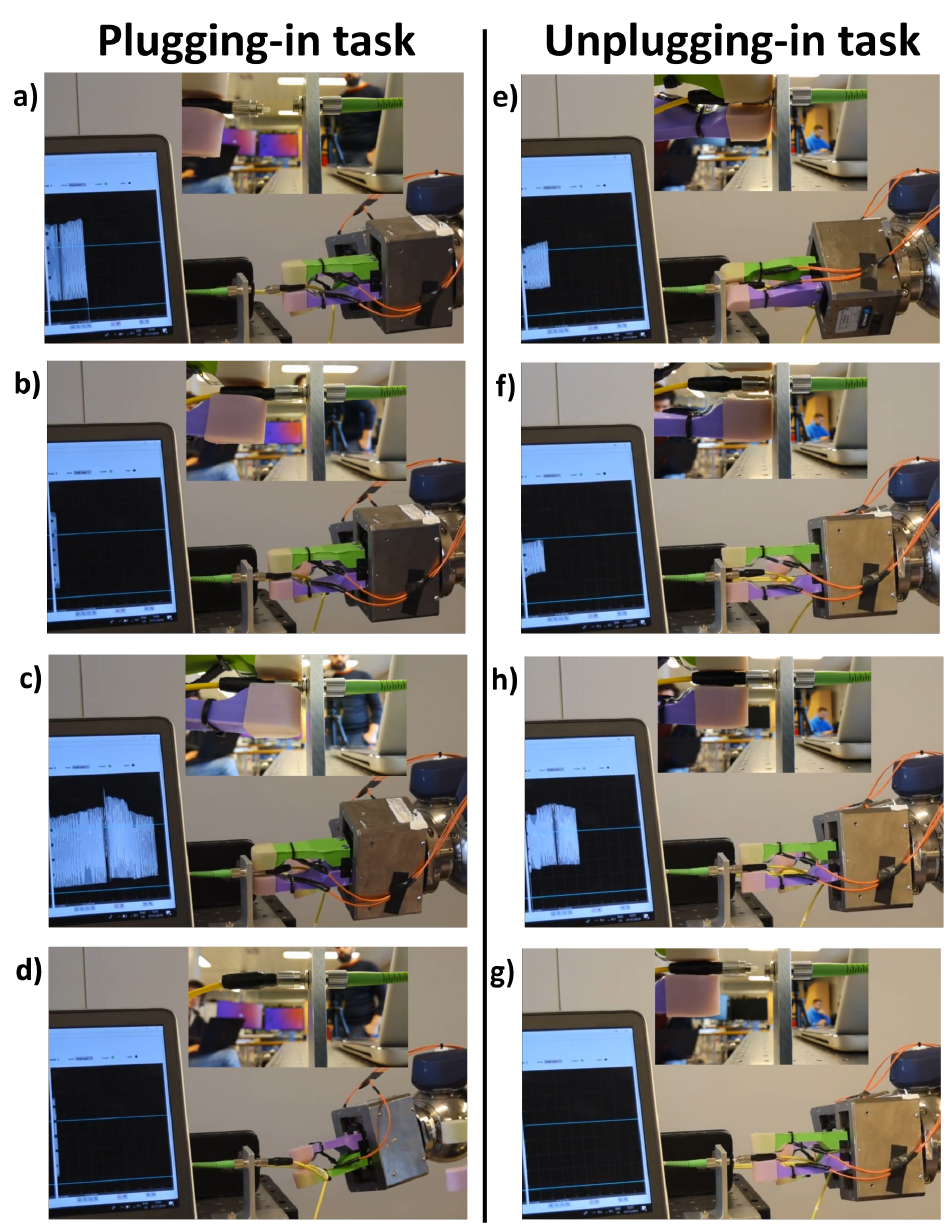
Figure 6. Different phases of the two tasks. ( a ) First step: the two grippers grasp the cable and the FC connector; ( b ) Second step: the left arm moves to plug-in the cable in the fiber optic coupler; ( c ) Third step: the gripper on the left arm releases the rigid part to grasp the rotating-threaded-receptacle part and to screw the connector; ( d ) Fourth step: the gripper on the left arm releases the rotating-threaded- receptacle part. ( e ) First step: the two grippers grasp the cable of the FC connector; ( f ) the gripper on the left arm releases the rotating-threaded-receptacle part; ( g ) the gripper on the left arm grasps the connector on the rigid part; ( h ) the right arm moves to unplug-in the